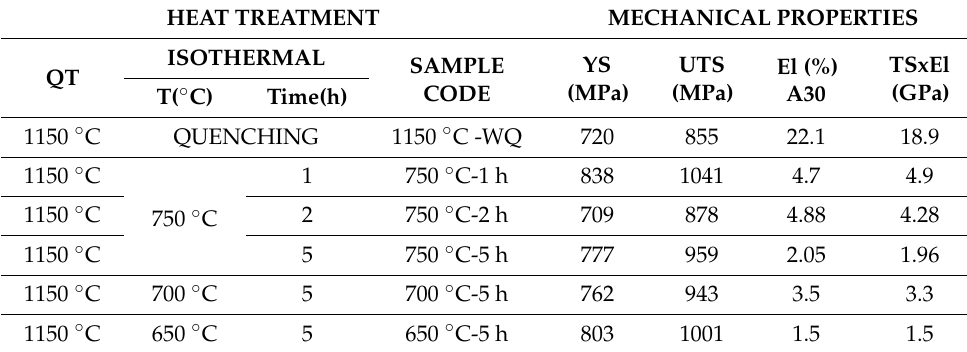
Figure 10. Tensile curves obtained for each heat treatment. Table 2. Mechanical properties obtained for the different